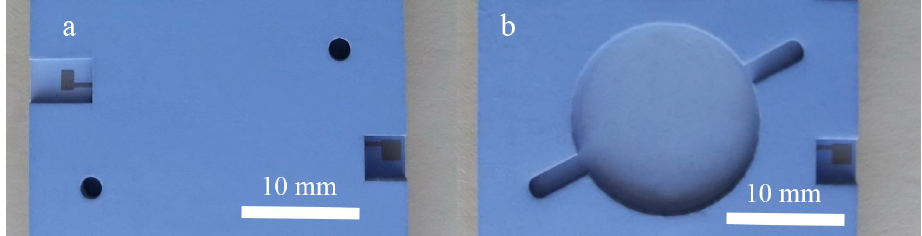
Figure 3. Photo of the structure for dielectric heating of the liquids. A complete structure is marked with ( a ) while the cavity is shown in structure without the lid in ( b ).